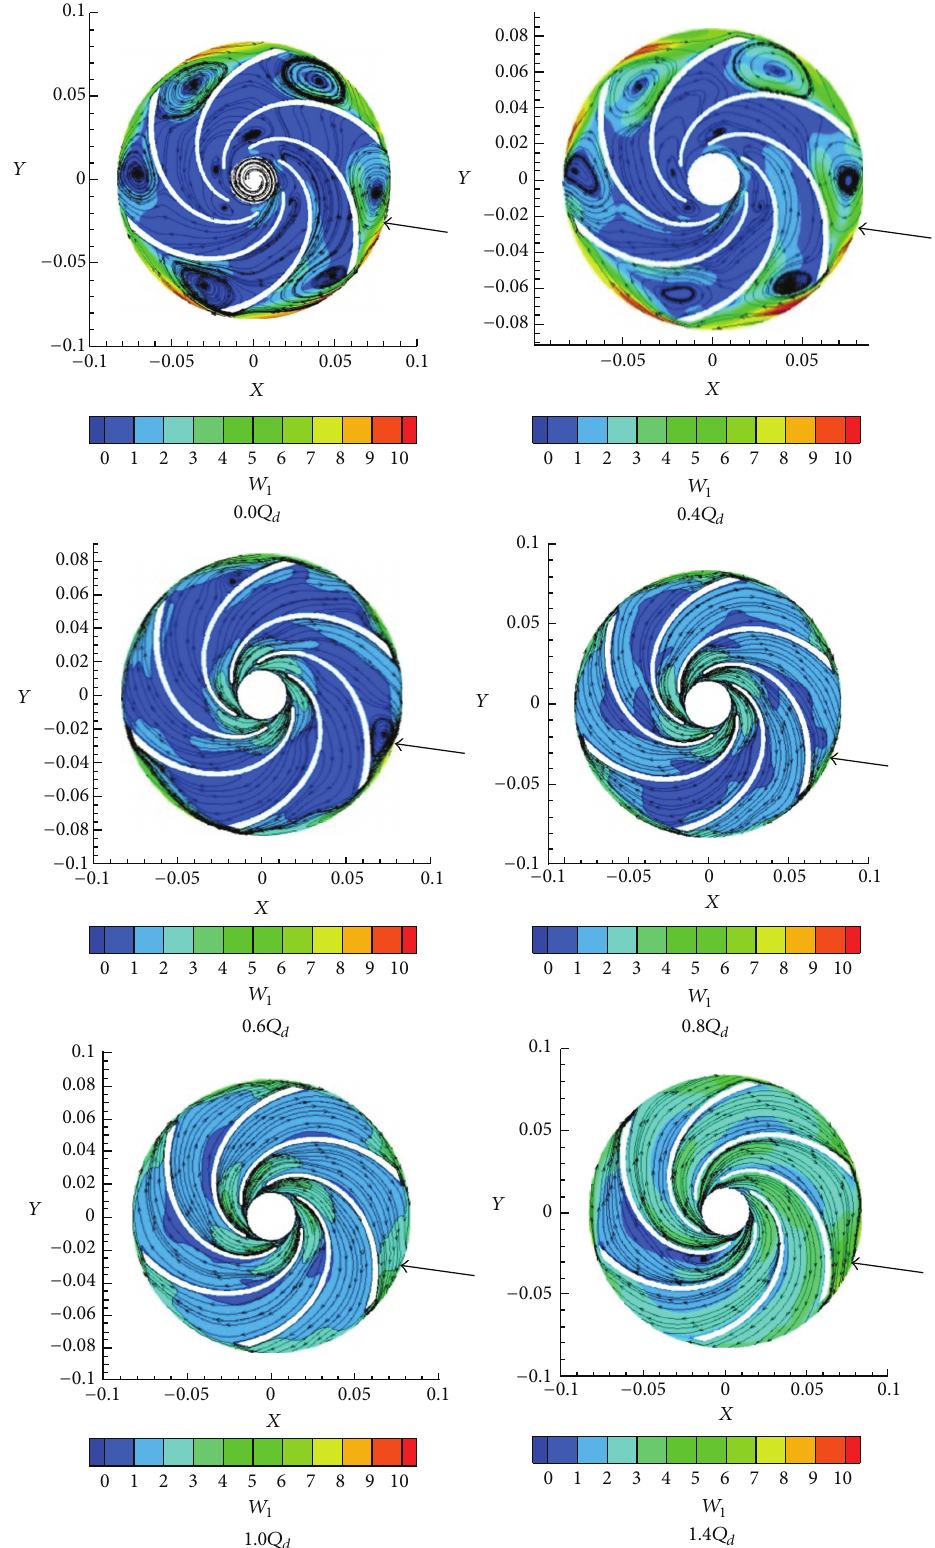
Figure 10: Contour of relative velocity and their visualization at different flow rates and position of